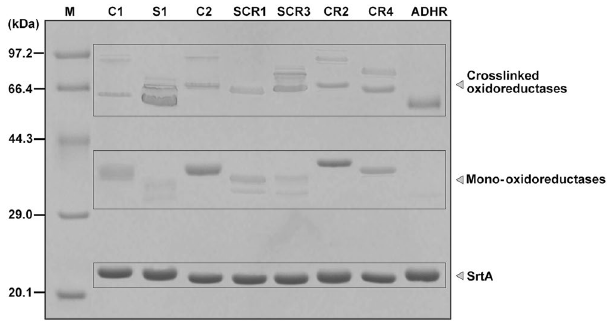
Figure 7. SDS-PAGE analysis of SrtA-mediated ligation of 8 oxidoreductases after incubating for 36 h. Mono- oxidoreductases included oxidoreductase-mtf, oxidoreductase-GGGGSLPET and cyclized oxidoreductase- GGGGSLPET. Ligation products, mainly dimers and trimers, were labelled as crosslinked